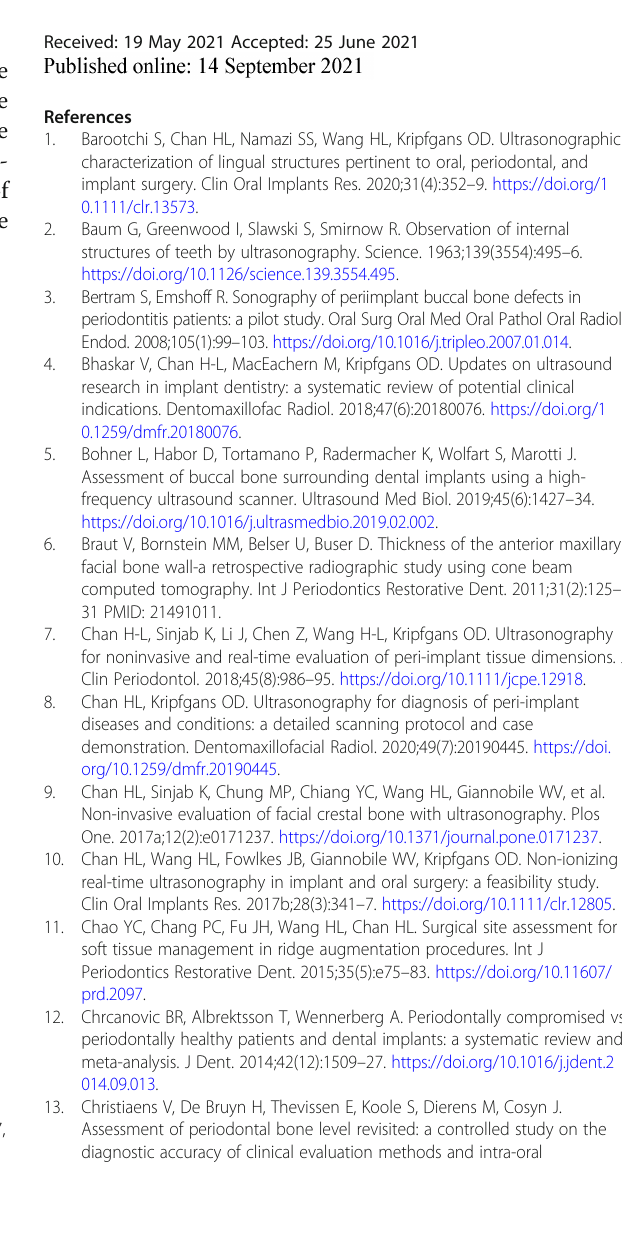
Fig. 15 a The intraoperative situation at the implant in region 43 reveals a buccal bone loss up to the 6rd thread. b The horizontal bone defect is 8 mm, and the vertical defect 3